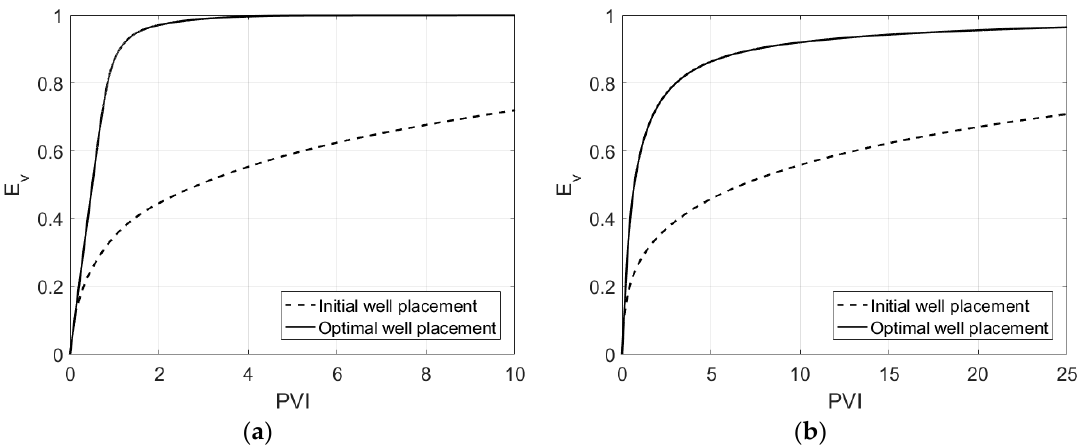
Figure 16. The sweep efficiency proxy plots illustrating the late time behavior of the initial and optimal P&T remediation designs for the heterogeneous ( a ) two- and ( b ) three-dimensional test problems.